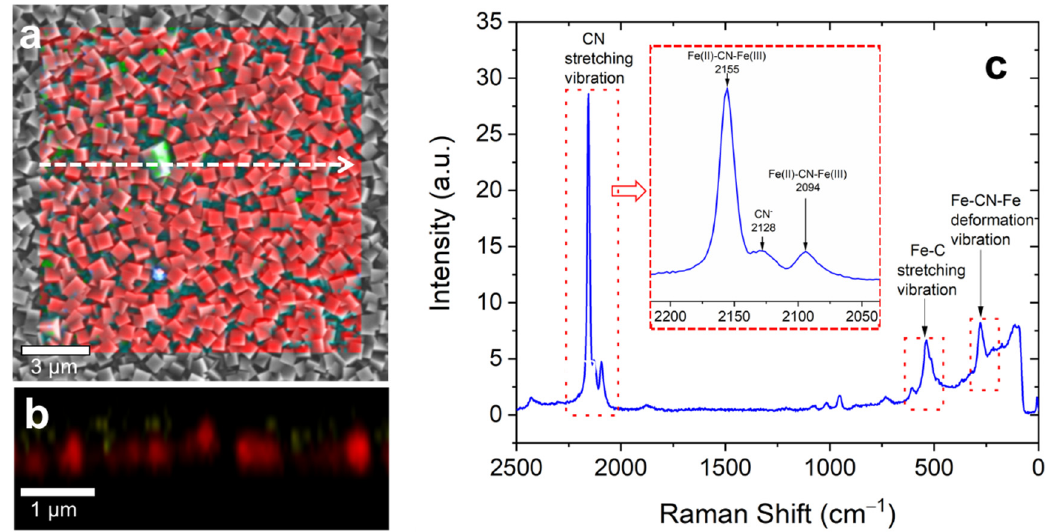
Figure 3. Raman imaging and spectroscopy of thin PB films electrodeposited with 30 mC at 0.3 V: ( a ) Raman area scan with an area size of 15 × 15 µm² (red color) combined with the SEM image of the same sample area. ( b ) Raman depth scan along the marked white arrow in the image ( a ). ( c ) Typical Raman spectrum corresponding to the red-colored regions of images ( a , b ). The inset shows the region of the CN-stretching vibration in detail. The Raman spectra were recorded at a laser excitation wavelength of 532 nm and a power of 1 mW.